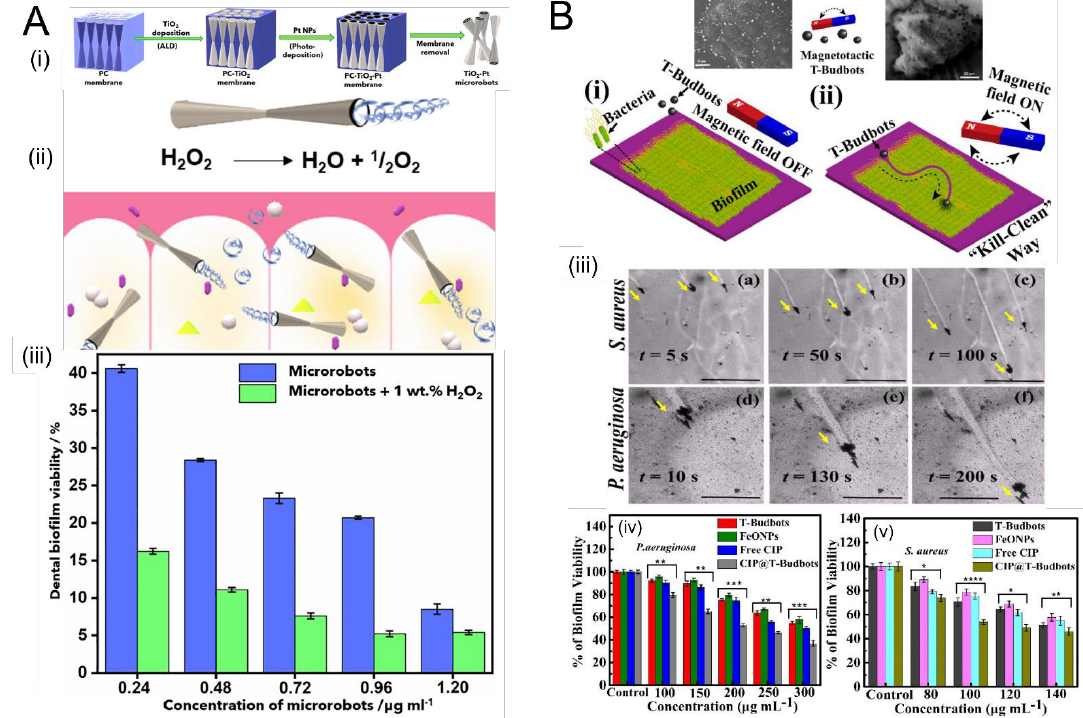
Figure 3. Use of self-propelled particles to disrupt bacterial biofilms. ( A ) (i) fabrication schematic for tubular titanium dioxide “microrobots” decorated with platinum (Pt) nanoparticles. The Pt nanoparticles catalyze the breakdown of hydrogen peroxide into oxygen and water, propelling the microrobots through the biofilm, which has potential applications for dental biofilms since H 2 O 2 is widely used in this area (ii). (iii) In the presence of microrobots and H 2 O 2 , the biofilm viability is decreased compared to the case of microrobots alone (blue; no H 2 O 2 fuel). Panel ( A ) adapted from [123]. Copyright © 2021 the authors. ( B ) (i,ii) Schematic of operation of “T-Budbots”, which are SPPs derived from natural tea plants and decorated with magnetite nanoparticles. These nanoparticles execute magnetic-driven motion through both Staphylococcus aureus and Pseudomonas aeruginosa biofilms (iii) at various time points (a – c, d – f). For both P. aeruginosa (iv) and S. aureus (v), the T-Budbots showed the most efficient reductions in biofilm viability compared to several controls (T-Budbots alone, magnetite nanoparticles alone, or free antibiotic alone). In panels (iv) and (v), statistical significance is signified by * (p < 0.05), ** (p < 0.005), *** (p < 0.001), and **** (p < 0.0001), evaluated by one-way analysis of variance (ANOVA). Panel ( B ) adapted with permission from [124]. Copyright © 2021 American Chemical Society.